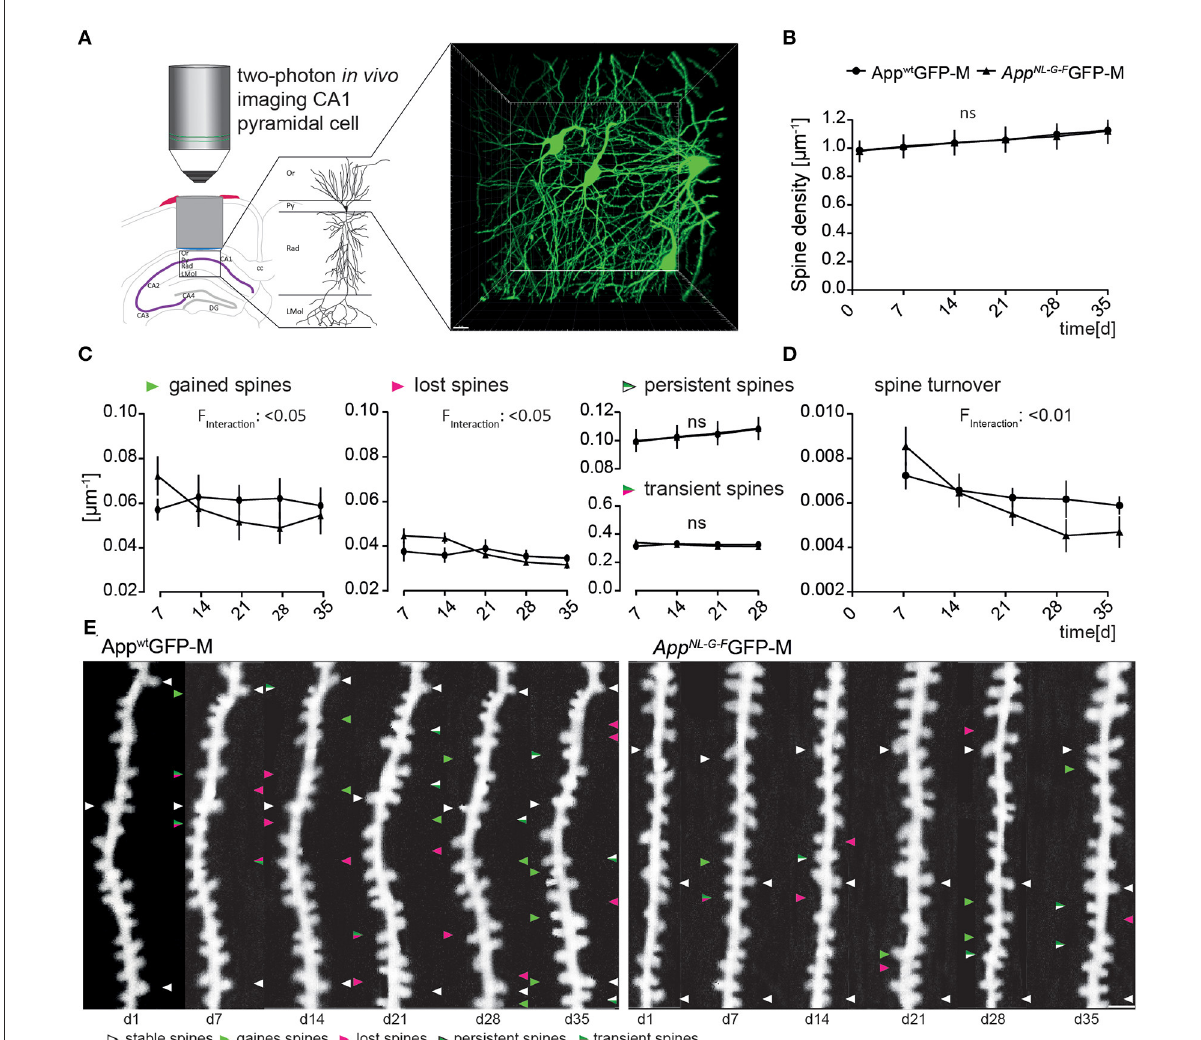
FIGURE2 The App NL − G − F mouse model showed altered plasticity of dendritic spine dynamics in vivo distant to A β -deposits. (A) Left, schematic illustrating two-photon in vivo microscopy of basal dendrites in the stratum oriens (Or) of the CA1-region in the hippocampus. Right, maximum intensity projection of a z-stack acquired up to a depth of 180 µ m below the corpus callosum comprising stratum oriens (SO), stratum pyramidale (Py) and stratum radiatum (Rad). Scale bar: 15 µ m. (B) The spine density distant to A β -deposits in App NL − G − F GFP-M mice was not significantly changed compared to App wt GFP-M mice ( p = 0.9753) (C) The fractions of gained ( p = 0.0208) and lost spines ( p = 0.0238) were significantly decreased in App NL − G − F GFP-M mice compared to App wt GFP-M animals, while the fractions of persistent ( p = 0.9593) and transient spines ( p = 0.9521) did not differ. (D) Consequently, the spine turnover ratio was significantly decreased in App NL − G − F GFP-M mice compared to App wt GFP-M mice ( p = 0.0064). (E) Representative in vivo two-photon recordings of eGFP-labeled basal tuft dendrites in the stratum oriens of CA1-region in the hippocampus in App NL − G − F GFP-M and App wt GFP-M mice. Arrowheads mark representative spines that were stable (white), newly formed (green), or lost (magenta). Gained spines that did not stabilize (green/magenta, present < 7 days) were defined as transient, whereas gained spines, that did stabilize were defined as persistent (green/white, present > 7 days). Scale bar: 2 µ m. N = 6 animals per group, n = 7–10 dendrites per animal. Data are presented as mean ± SEM. Bonferroni post-hoc test results from two-way